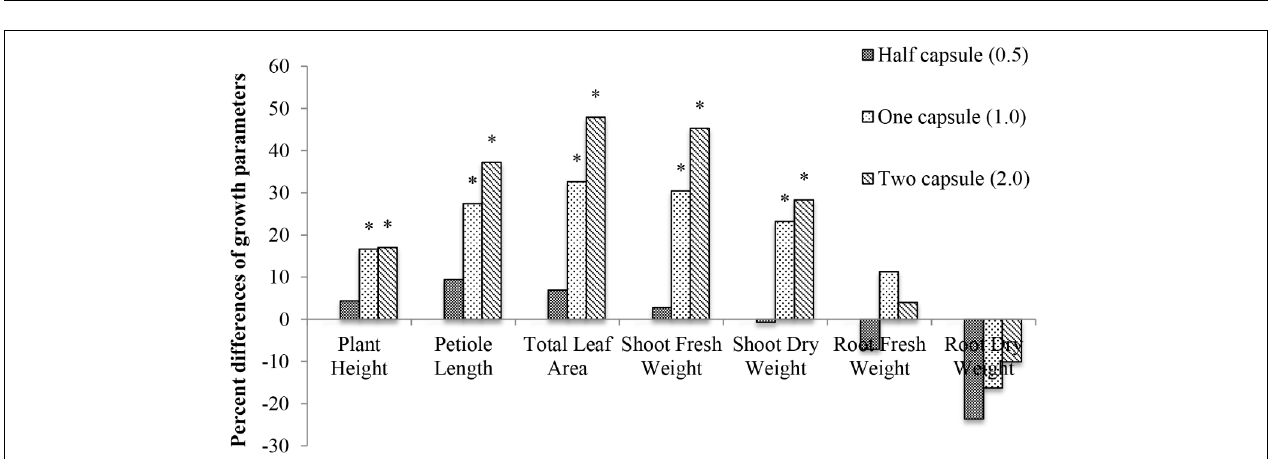
FIGURE 3 | Mean dry weight 28 days after emergence of six crops: cucumber, arugula, broccoli, tomato, pepper, and with five treatments: control, half capsule (0.5), whole capsule (1.0), two capsules (2.0), and three capsules (3.0). Data analyzed by ANOVA ( α = 0.05) and Tukey’s HSD test was used to conduct mean separation comparison. Letters not associated with same letter are significantly different.